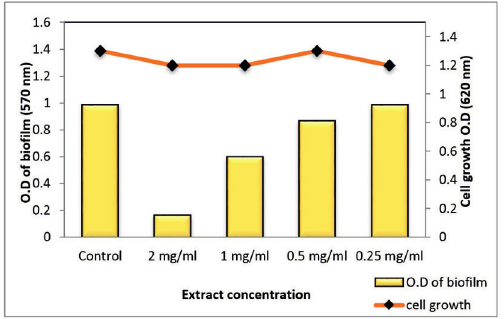
Fig. 11. Effect of sub-MICs of polyphenol fraction Z. spina-christi on biofilm formation of MRSA strain 3.6.2.